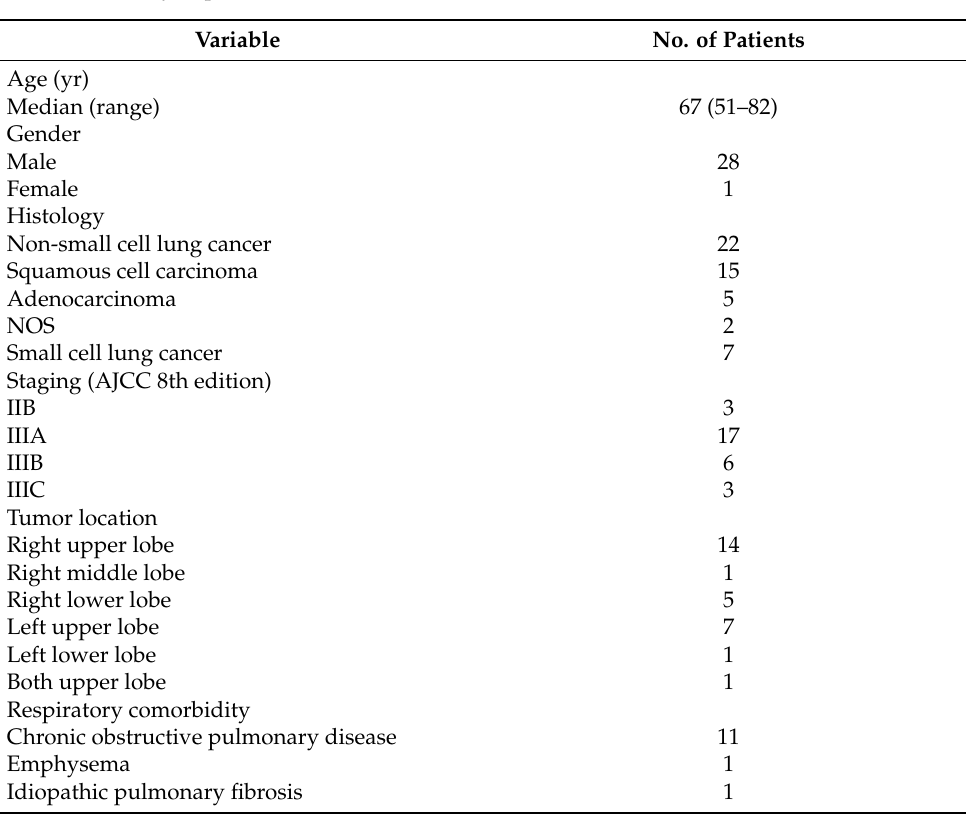
Figure 1. Study workflow chart. Table 1. Summary of patient characteristics.